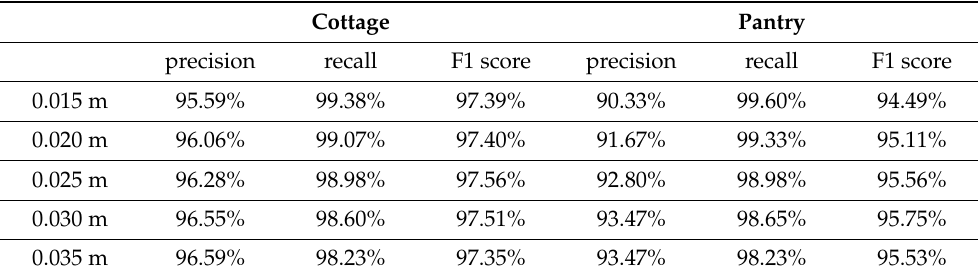
Table 3. Assessment of segmentation results for data using the proposed method under different distance thresholds.